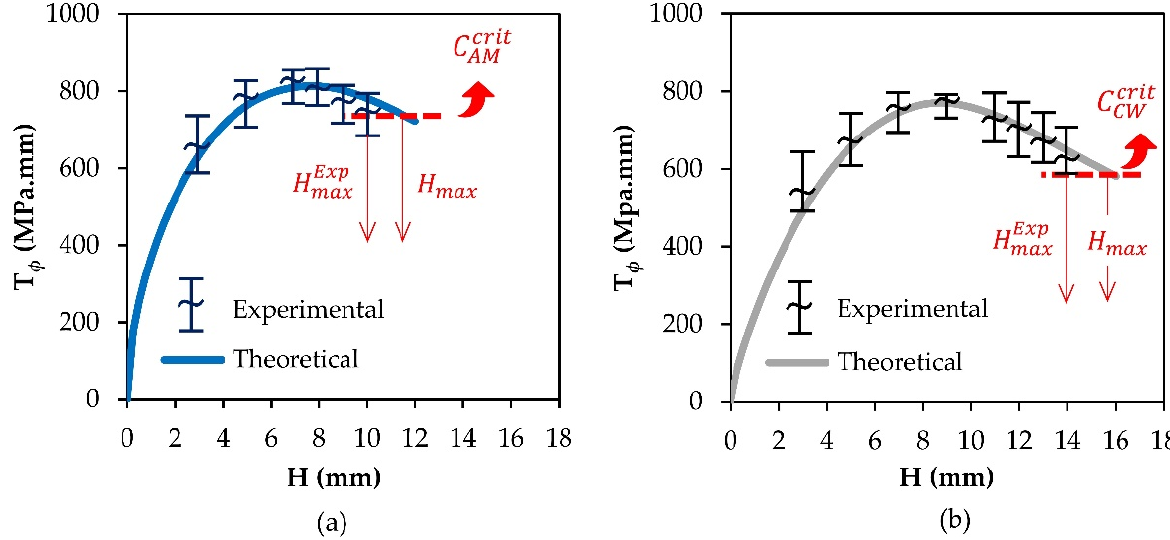
Figure 8. Evolution of the force per unit of length with the groove depth for the ( a ) additively deposited and ( b ) wrought commercial AISI 316L stainless-steel sheets. The dashed horizontal lines in both graphics correspond to the critical values and the intersections provide the maximum allowable predicted depths H max .